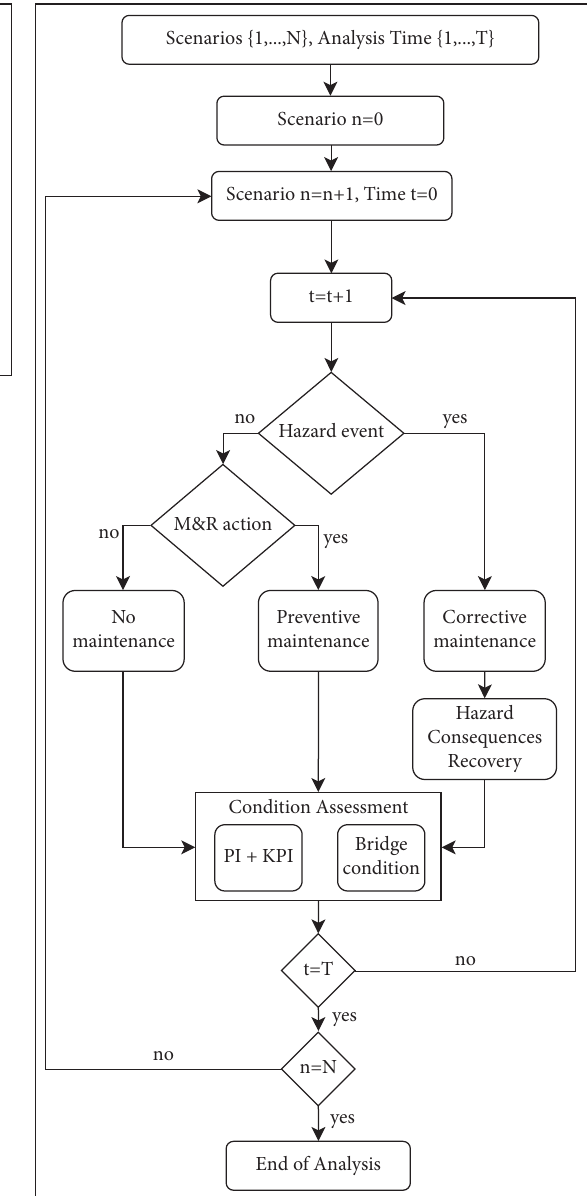
Figure 1: Flowchart of the presented methodology for the assessment of existing